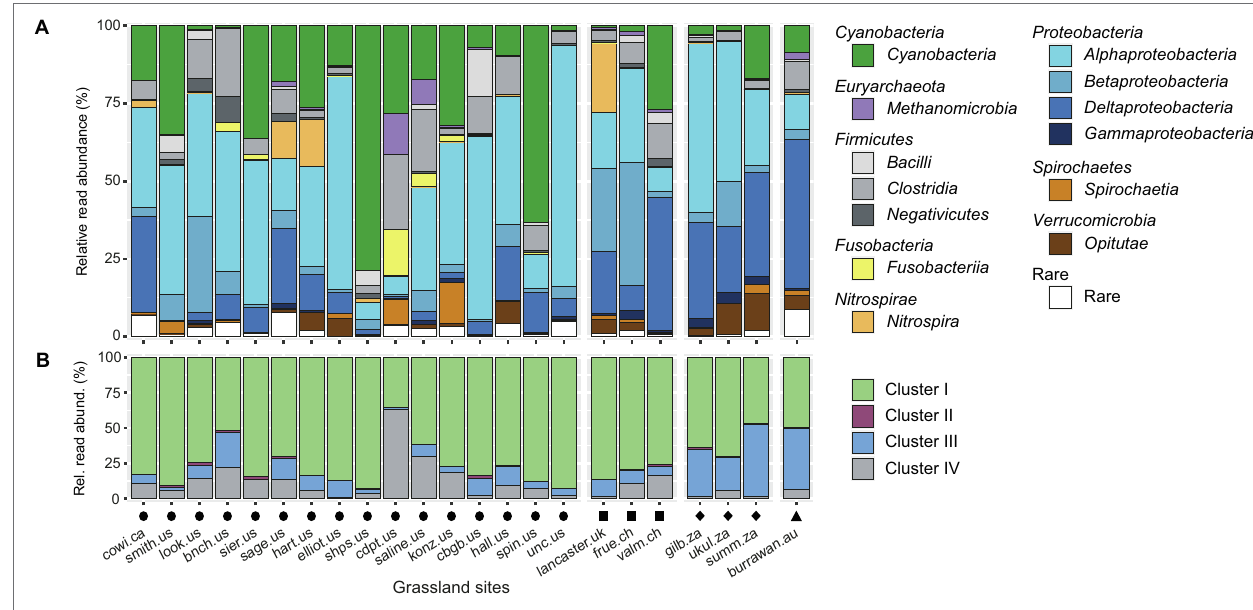
FIGURE 2 | Diazotrophic community composition per grassland site. (A) Taxonomic affiliation of OTUs summarized at the class level based on BLASTP analysis; (B) relative read abundances of phylogenetic nifH clusters based on classification and regression trees (CART) analysis. On the x -axis, every bar represents the average community per study site, sorted according to longitudinal coordinates, whereas the y -axis shows the relative read abundance of taxonomic classes (A) or phylogenetic nifH clusters (B) . Shapes above the grassland site names denote the respective continent (circle: North America, square: Europe, diamond: Africa, triangle: Australia).